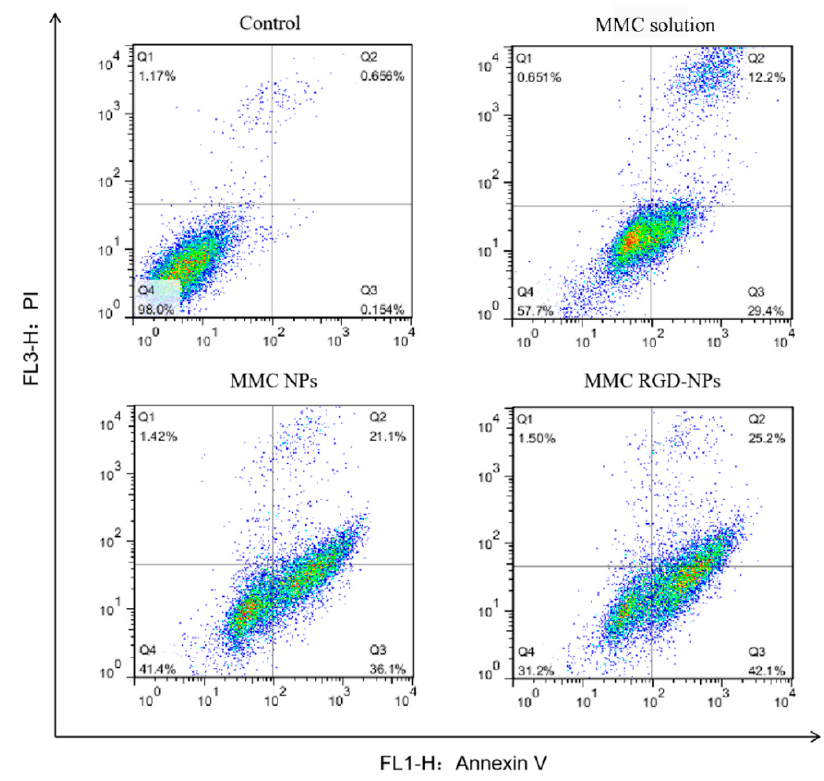
Figure 11. Influence of MMC NPs on cell apoptosis analyzed by flow cytometry.